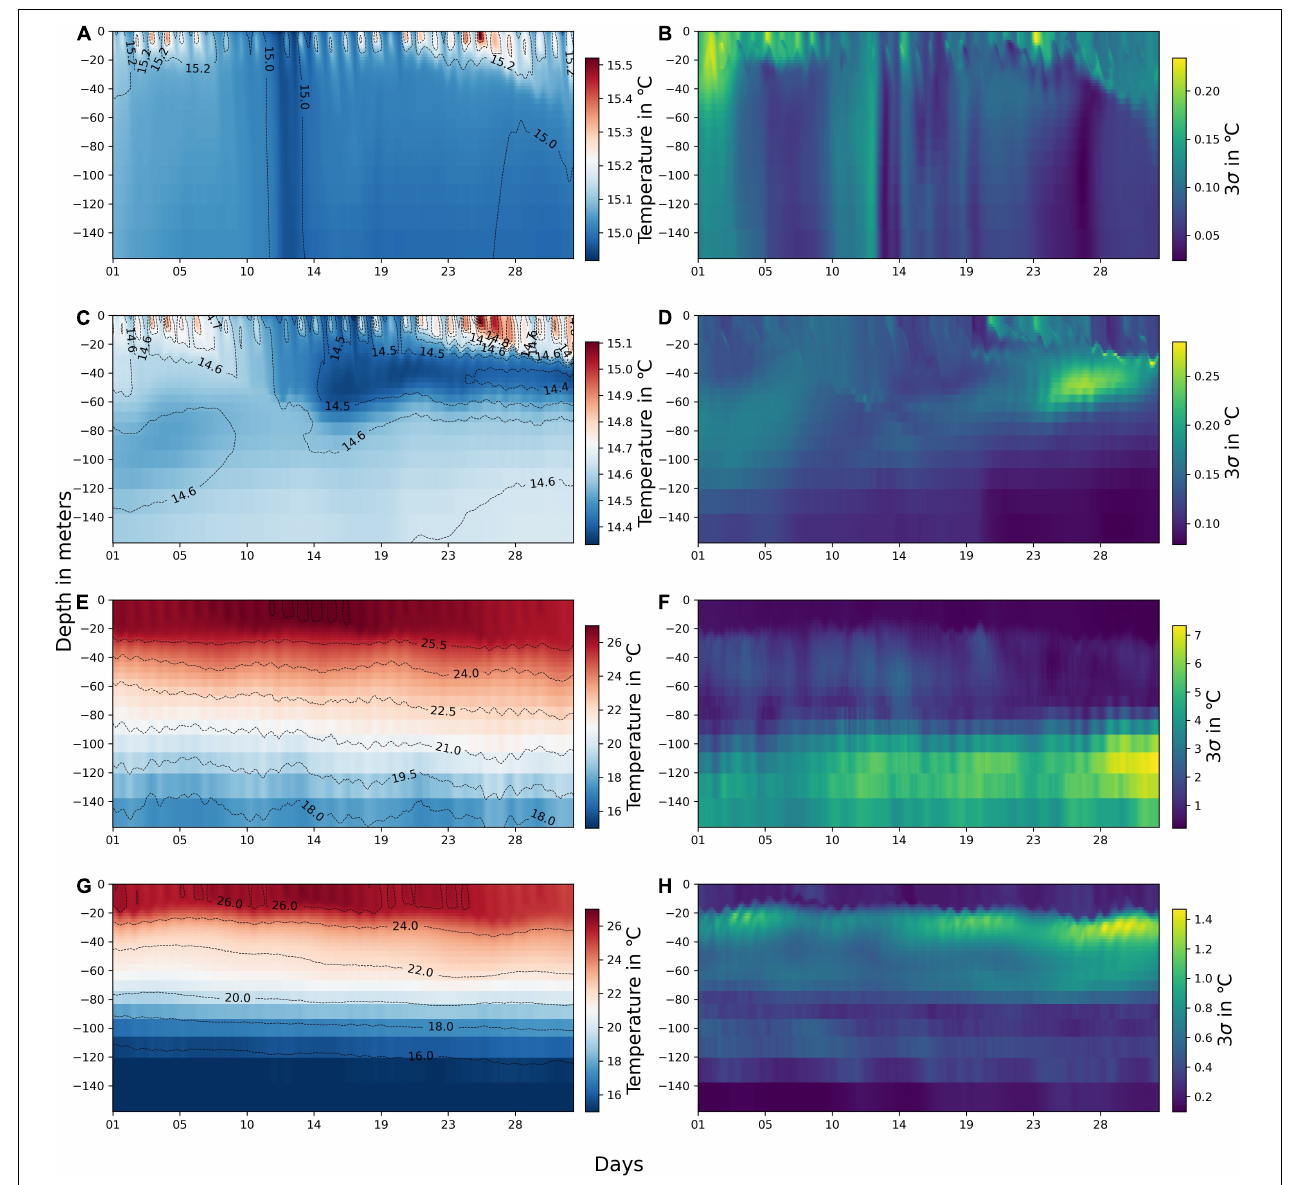
FIGURE 5 | Ensemble mean and ensemble spread of vertical SWT (A) Mean – Ortholithi March 2017, (B) 3 standard deviations ( σ ) – Ortholithi March 2017, (C) Mean – Ovrios March 2017, (D) 3 σ – Ovrios March 2017, (E) Mean – Ortholithi August 2017, (F) 3 σ – Ortholithi August 2017, (G) Mean – Ovrios August 2017, and (H) 3 σ – Ovrios August